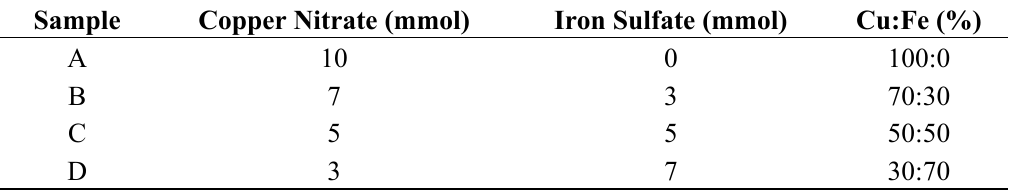
Scheme 1. General synthetic technique for Cu-Fe-S nanoparticles. Table 3. Input molar ratio of metallic precursors for the Cu-Fe-S nanoparticle